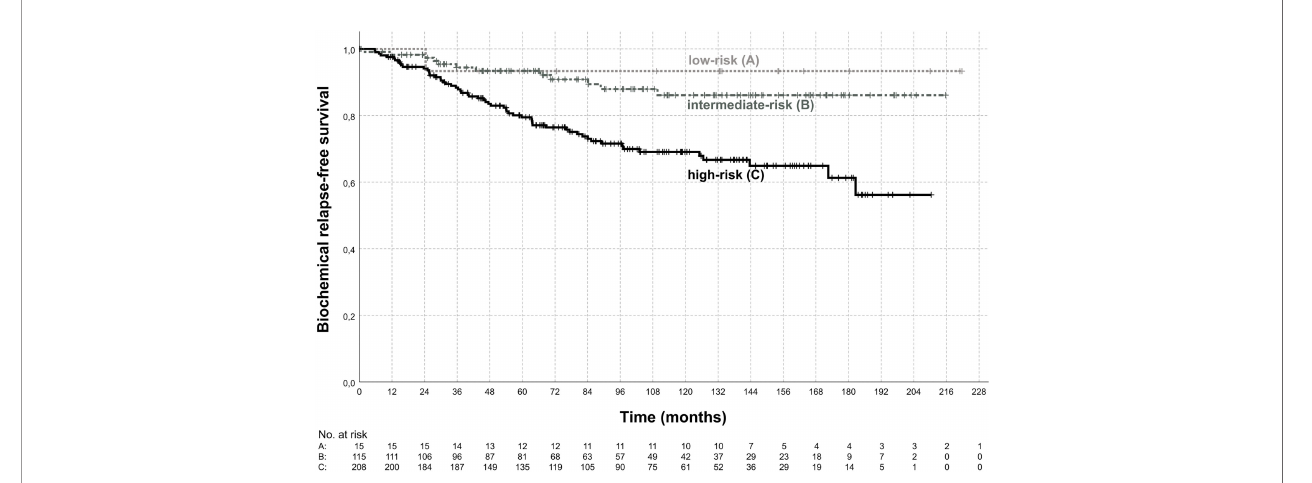
FIGURE 3 | Biochemical relapse-free survival. Shown is the biochemical relapse-free survival according to risk group for the low-risk group (A) , intermediate-risk group (B) , and high-risk group (C) . The estimated biochemical relapse-free survival at 5-years was 93.3%, 93.4%, 79.5% for low-, intermediate-, high-risk disease, respectively. Biochemical relapse-free survival was signi fi cantly different between intermediate-risk and high-risk (p < 0.01, log-rank test).